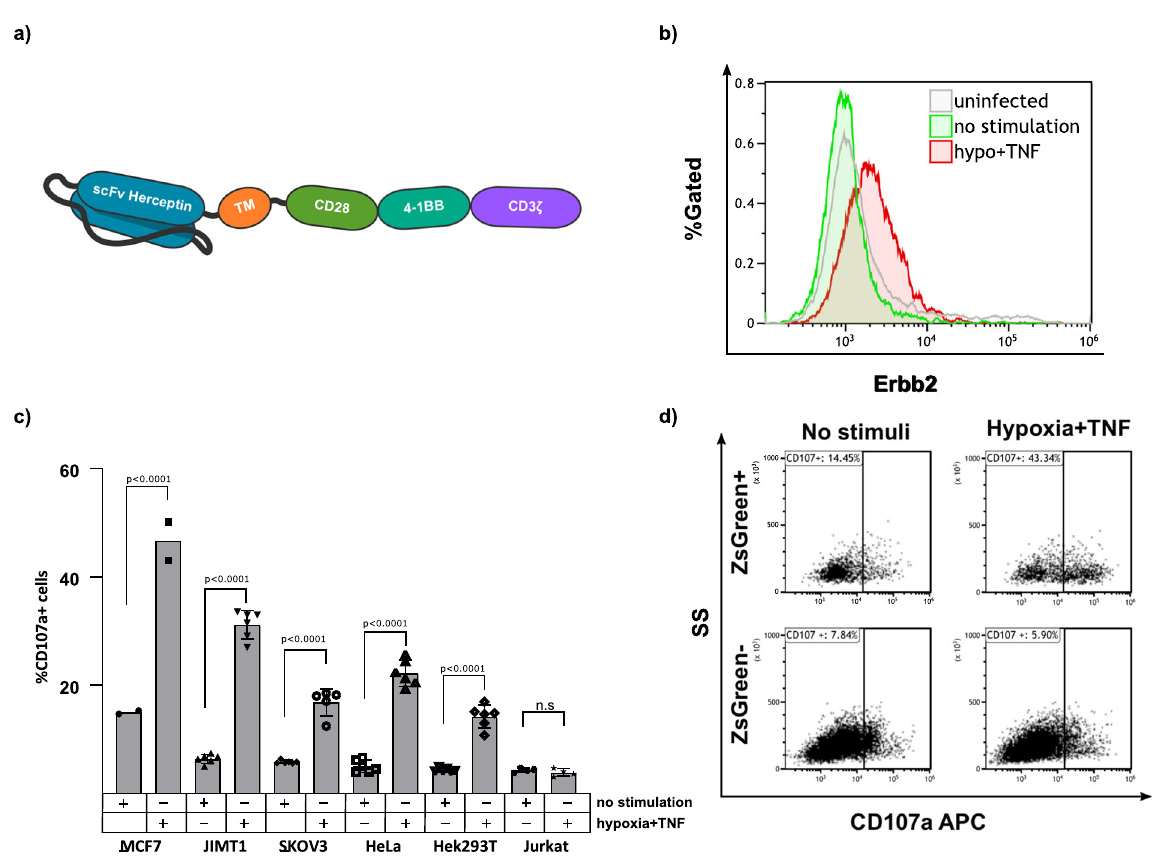
Fig. 6 CARTIV promotors allow inducible expression of a Herceptin-based CAR, leading to degranulation against HER2-expressing target cells. a Schema of the CAR used. b Representative plot of human primary T cells incubated for 48 h with 250 U/mL of TNF α and for 18 h under hypoxic or normoxic conditions. The cells were then stained using an Erbb2-Fc chimeric protein and analyzed by FACS. Data shown are ZsGreen-positive, single- discriminated, and DAPI-negative results. c %CD107a positive and ZsGreen positive human primary T cell following 48 h with 250 U/mL TNF α and for 18 h under hypoxic conditions and incubation with the indicated target cell line. Percentage of CD107a positive cells is normalized to the total number of ZsGreen positive cells. An ordinary one-way anova was performed to test for signi fi cance, Error bars indicate standard deviation. d CD107a expression following incubation with MCF7 cells of ZsGreen positive and negative human primary T cells with and without the indicated stimuli. Results for b are from one representative experiment of four performed; c summarizes 2 – 6 experiments